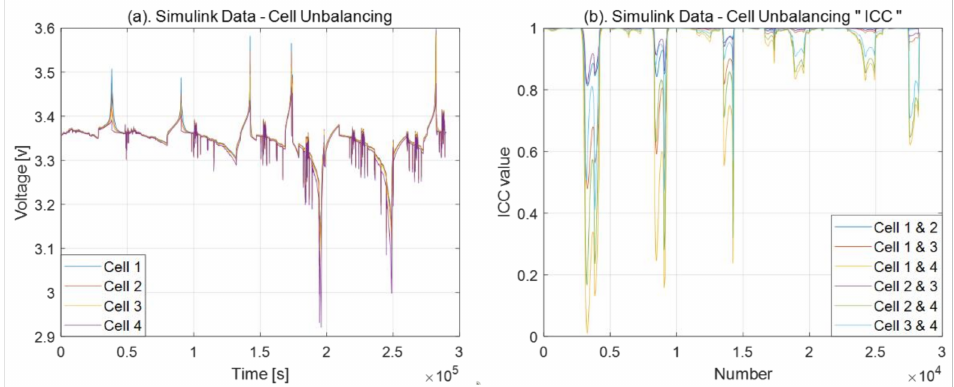
Figure 10. Simulink data with a cell balancing problem (( a ) voltage and ( b ) ICC value). Figure 11 data is filtered, and the order of the voltage is determined. When the filtered voltage data are listed according to the voltage level, it may be seen that the filtered voltage data are arranged in order from the high initial SOC, which shows a result similar to the resistance problem. To distinguish it from the resistance problem, identify the cells that reach the cut-off voltage in the order of the suggested flow